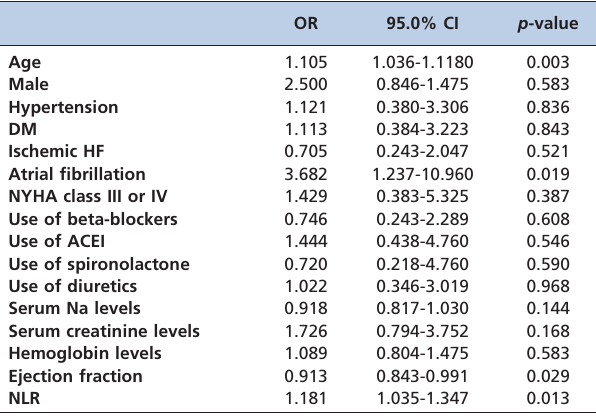
Table 2 - Univariate analysis of risk factors. Table 3 - Multivariate regression